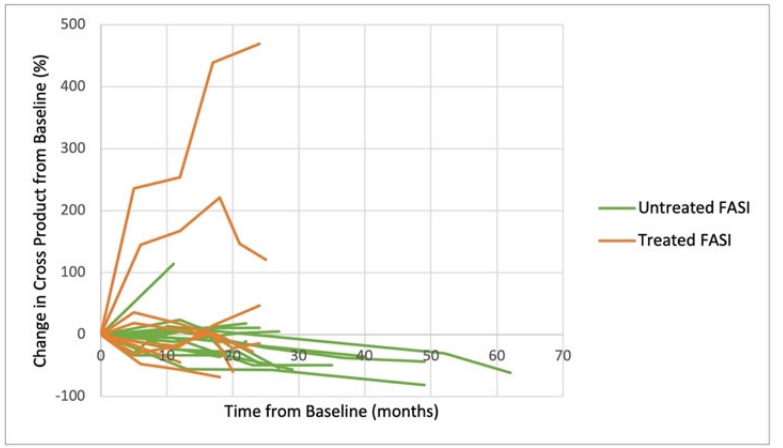
Figure 5. Change from the baseline in the size of the thalamic and lentiform FASI. Spider plot demonstrates the decrease in most untreated FASI with a substantial increase in two treated FASI.